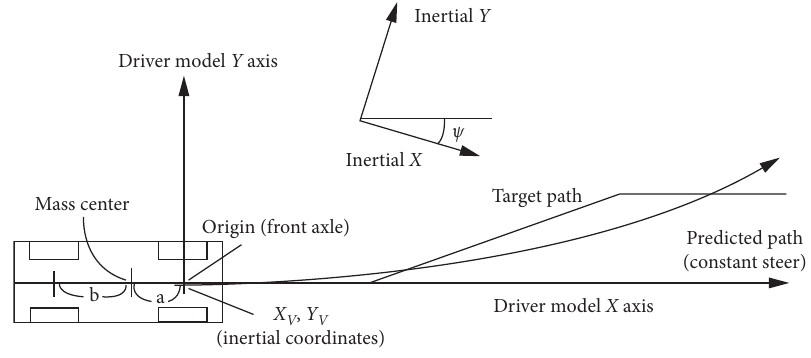
Figure 4: Axis system of the steering controller.